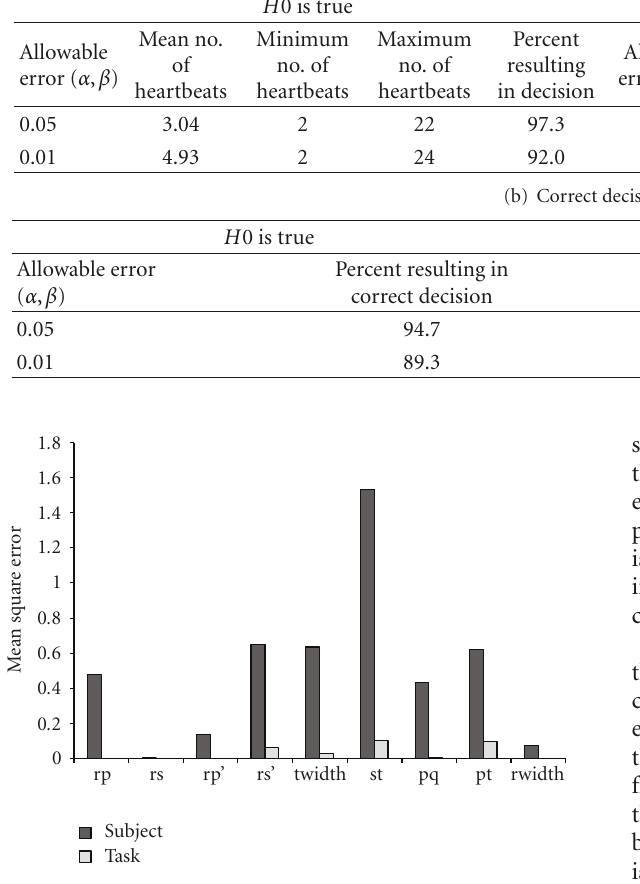
Figure 13: Comparison of variance attributable to subject and